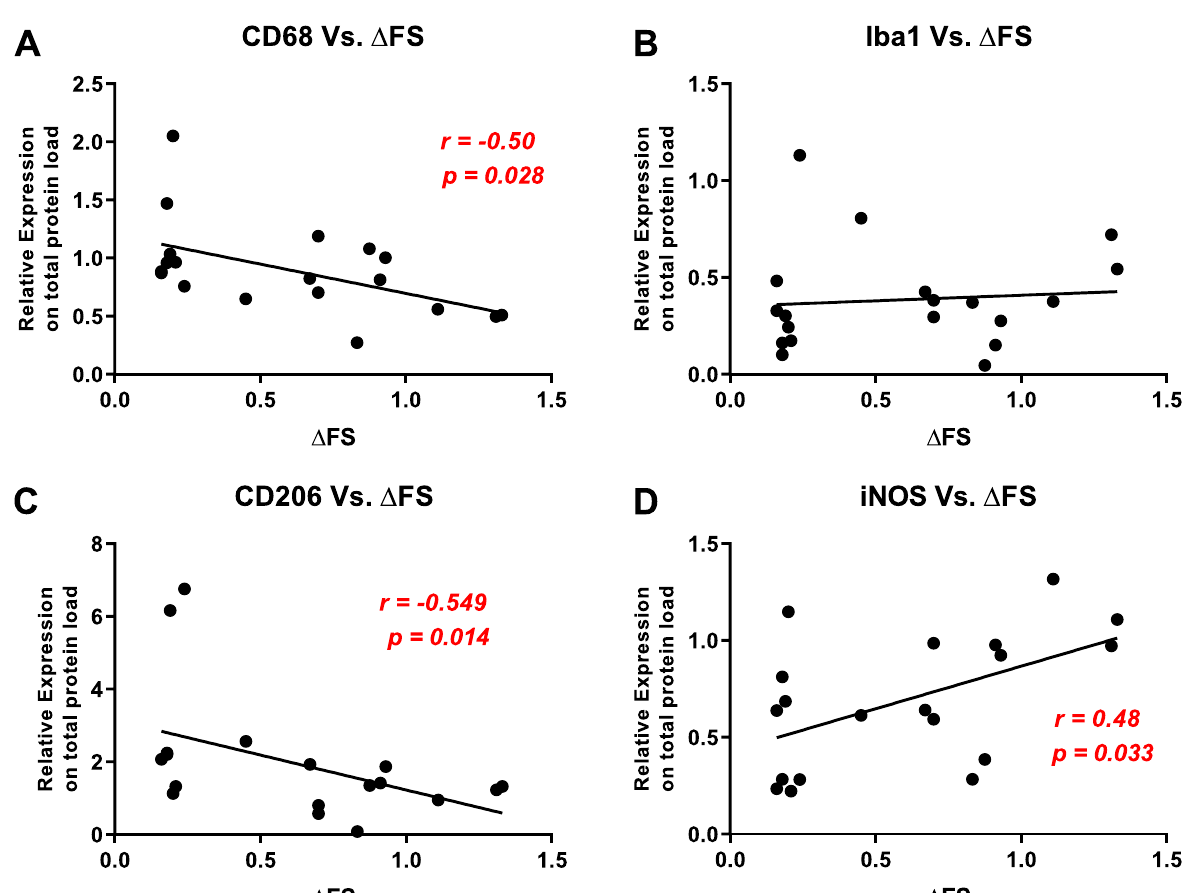
Fig. 8 The macrophage fingerprint correlates with the slow disease progression in sporadic ALS patients. A – D Bivariate analysis showing the strength of association between the muscular protein expression of CD68 ( A ), Iba1 ( B ), CD206 ( C ), and iNOS ( D ) assessed by immunoblot and the Δ FRS score of ALS patients. The higher is the Δ FRS, the faster is the disease progression. The data were analysed by nonparametric Spearman’s rank